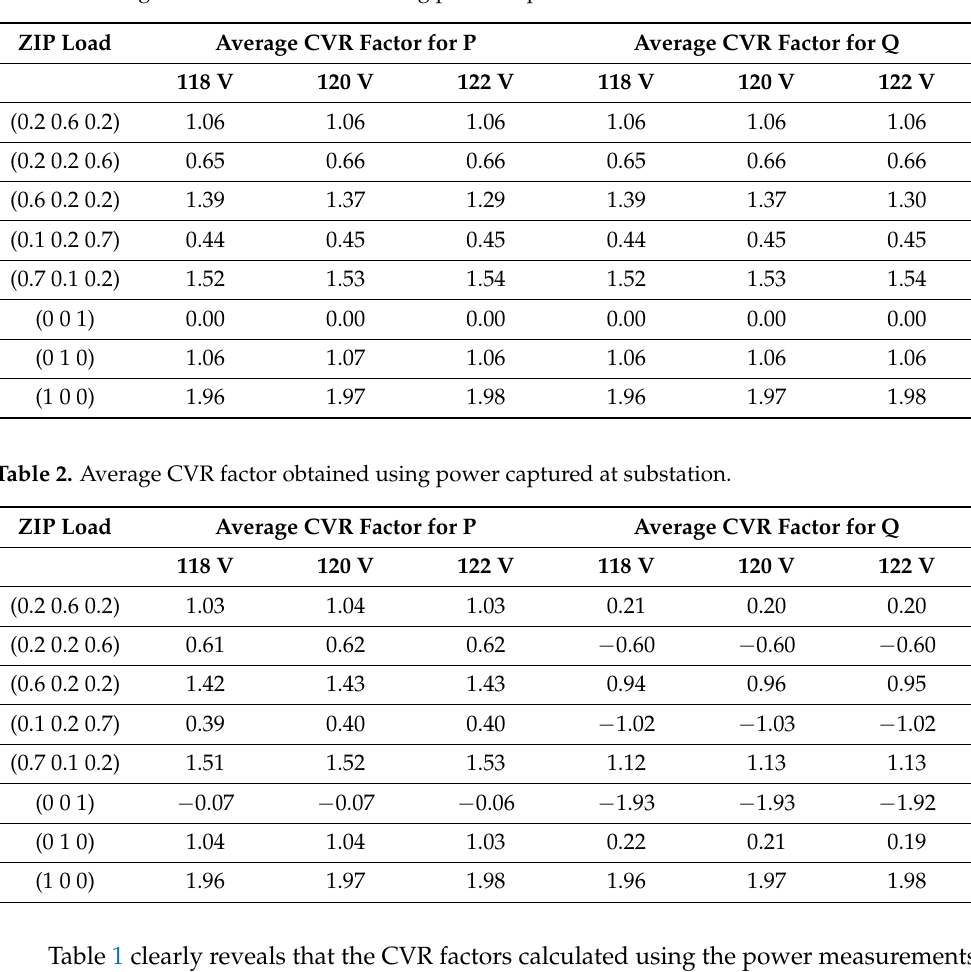
Table 1. Average CVR factor obtained using power captured at loads.